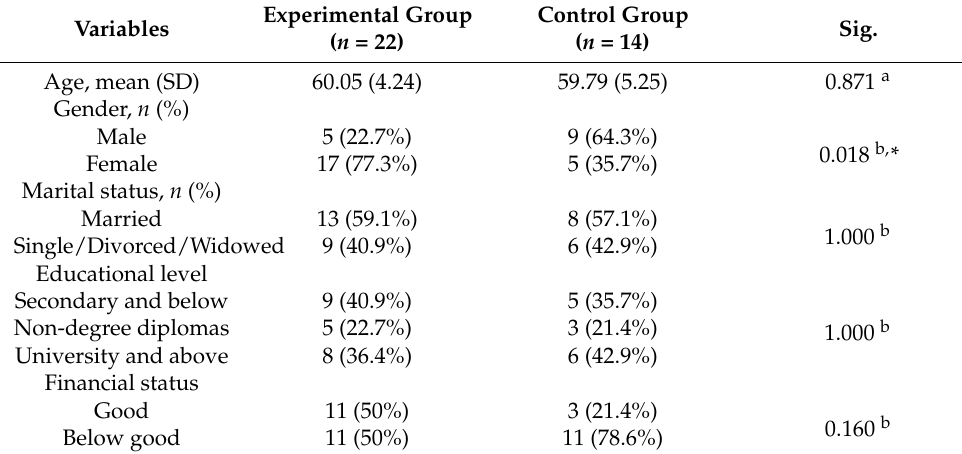
Table 1. Participants’ demographic